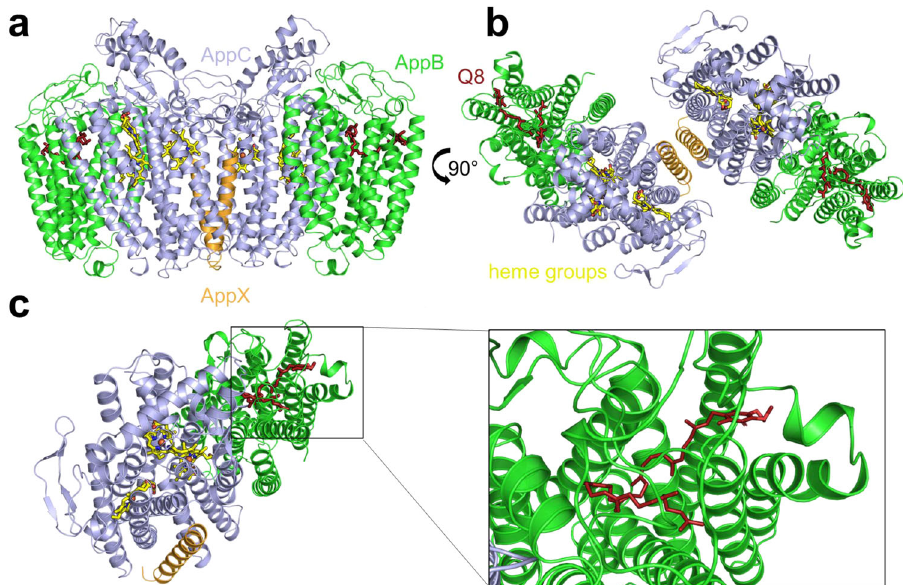
Fig. 2 Cryo-EM structure of the E. coli bd -II dimer at 3.0 Å resolution. a Front view with AppC (blue) and AppB (green), comprising nine TM helices, each. AppX (orange) is a single TM helix that stabilizes the four-helix bundles, coordinating hemes b 595 and d (yellow). The positions of heme b 558 (yellow) and of ubiquinone-8 (red) are indicated. b Top view on the dimer with fully resolved Q-loop. c Position of bound ubiquinone-8 (red, shown as sticks). The inset shows how the quinone is bound to 6 helices of subunit